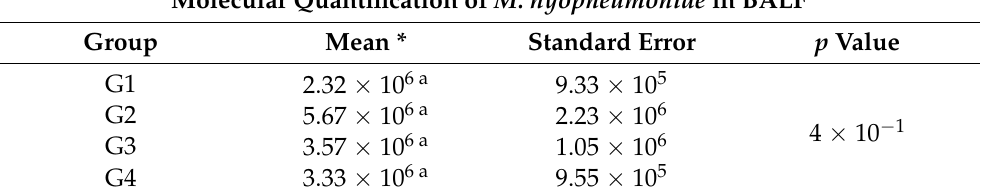
Table 6. Mean quantification of M. hyopneumoniae DNA (copies/ µ L) in bronchoalveolar lavage fluid at slaughter in the four different